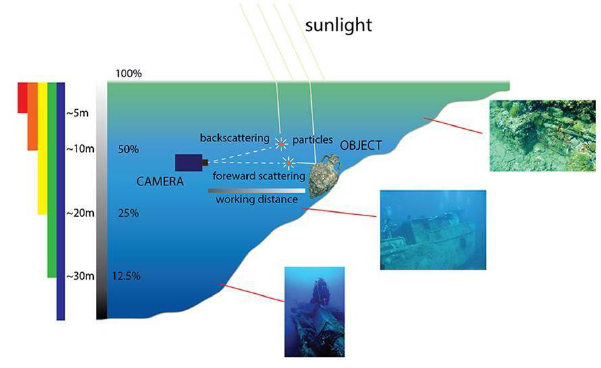
Figure 6. Color loss representation (Bianco et al, 2015) Our application calculates the light’s color loss and intensity based only on the depth of the submerged player. The loss of intensity and color is calculated by using linear interpolation, separately for each component of the light’s color (Red, Blue and Green) to approximate the color loss observed on the graph above. To improve visibility and return the lost colors to objects, player has a head mounted flashlight producing pure white light. Caustics, an element often present in underwater simulations, are not present deeper than 20 meters. This effect is usually faked by projecting a 2D texture on the surface and moving the texture offset, to make their movement animated. While caustics can improve the visual aspect of the application, they are not included in our simulation, because the Mazotos shipwreck is located at -44 meters.